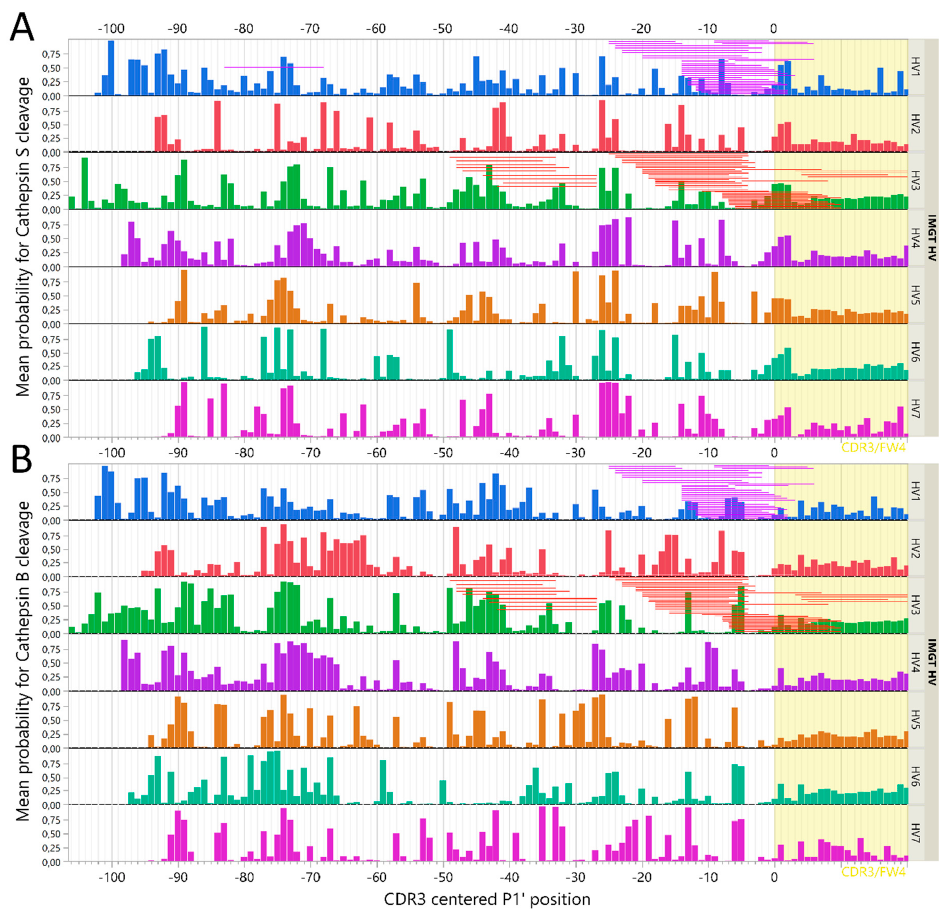
Figure 8. Predicted cleavage patterns of IGHV families using GenBank IGHV set. Approximately 16,000 curated IGHV sequences were divided by their V-family and analyzed with the cathepsin cleavage models. All possible cleavage site octamers (CSO) for each IGHV were aligned according the relative position of P1 ′ to the CDR3 (yellow) region cysteine (x-axis). Mean predicted probability for CSO cleavage at each position by cathepsin S ( A ) or cathepsin B ( B ) is shown on the y-axis. Superimposed are aligned IGHV peptides described by Khodadoust et al. (31), eluted from HLA class II of mantle cell lymphoma: MCL065 (purple) and MCL052 (red).